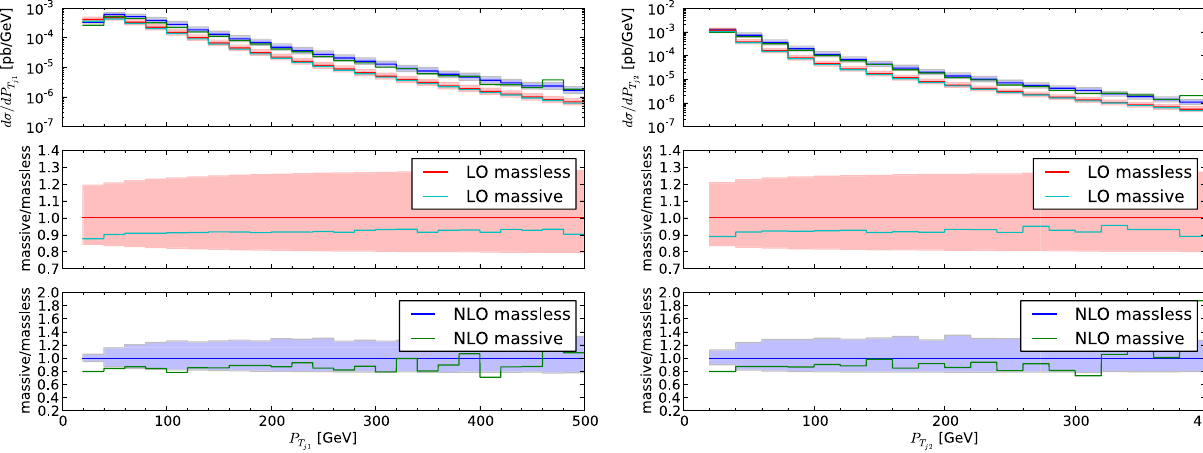
Fig. 8 Transverse momentum distribution of the two leading jets for massive b -quarks